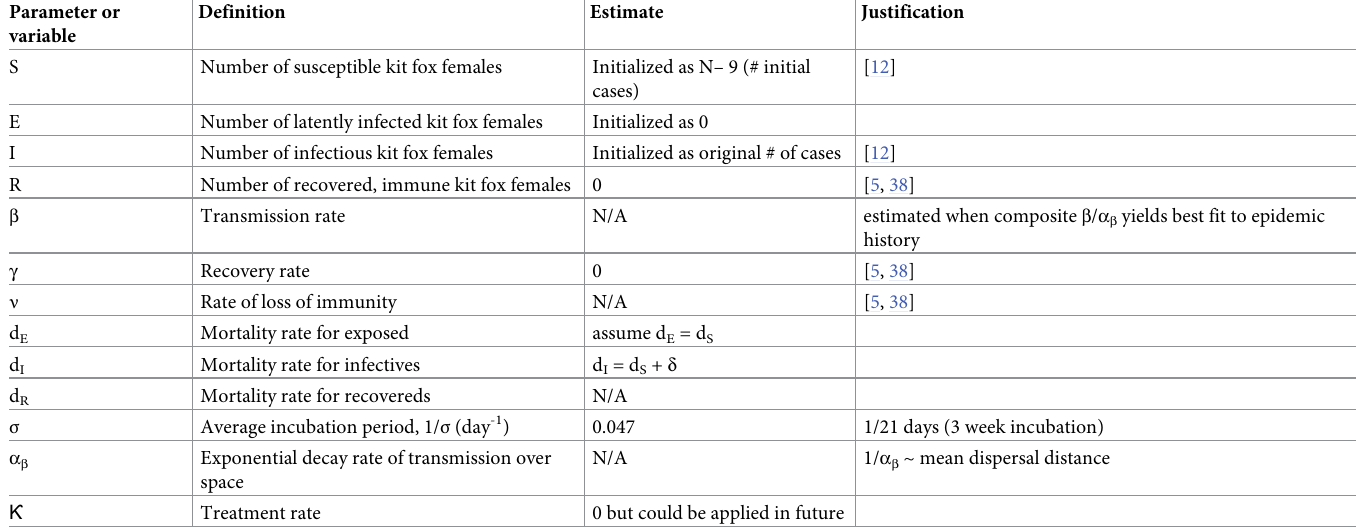
Table 3. Definition and estimates of mange variables and parameters for model metaseir, a stochastic, discrete-time compartment and metapopulation model for mange and population dynamics, applied to San Joaquin kit foxes in Bakersfield, California. Parameter or